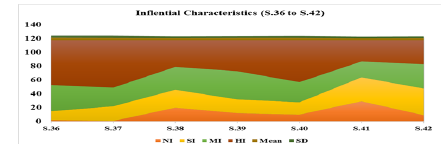
Figure 5: Influential Characteristics and their Properties of S.36 to